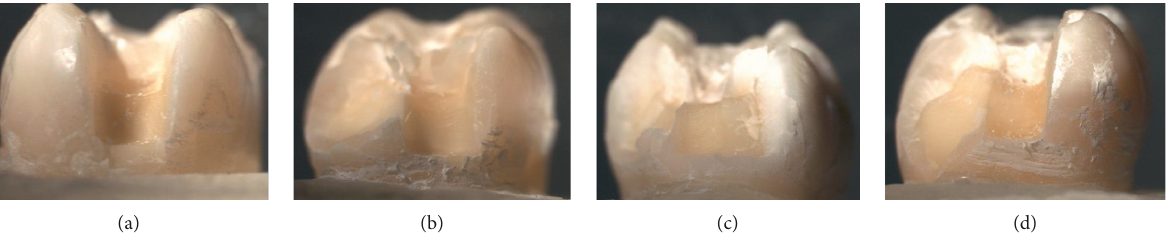
Figure 4: Fracture modes. (a) Type 1. (b) Type II. (c) Type III. (d) Type